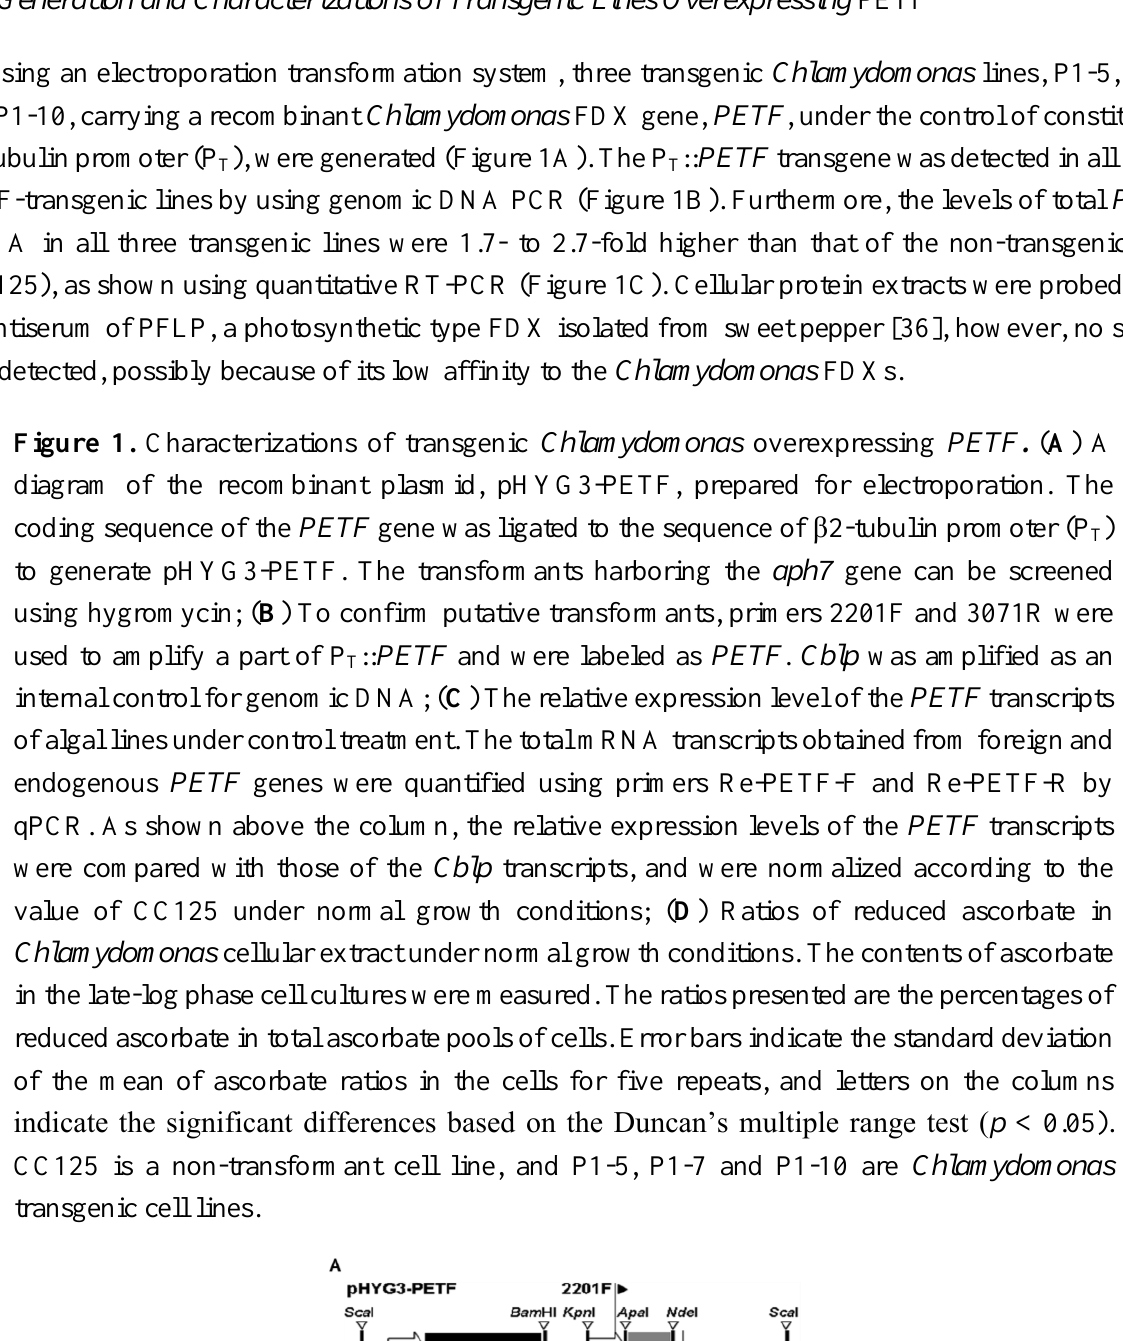
Figure 1. Characterizations of transgenic Chlamydomonas overexpressing PETF. ( A )